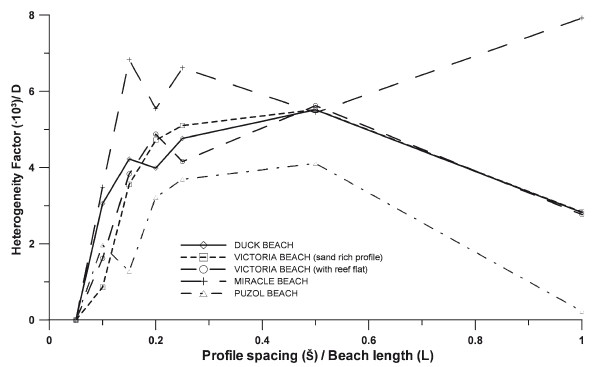
Fig . 5. – Heterogeneity distribution with respect to beach profile spacing/beach length (s/L) for each beach studied.